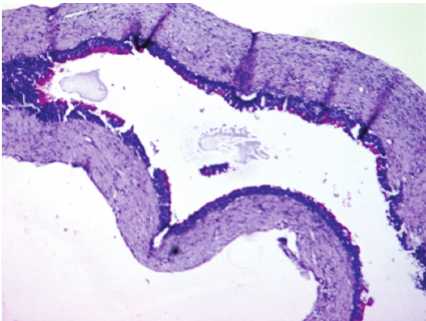
Figure 8: Photomicrograph of the lesion showing glandular cystic lining with mucicarmine positive mucus cells (H&E, 10x).